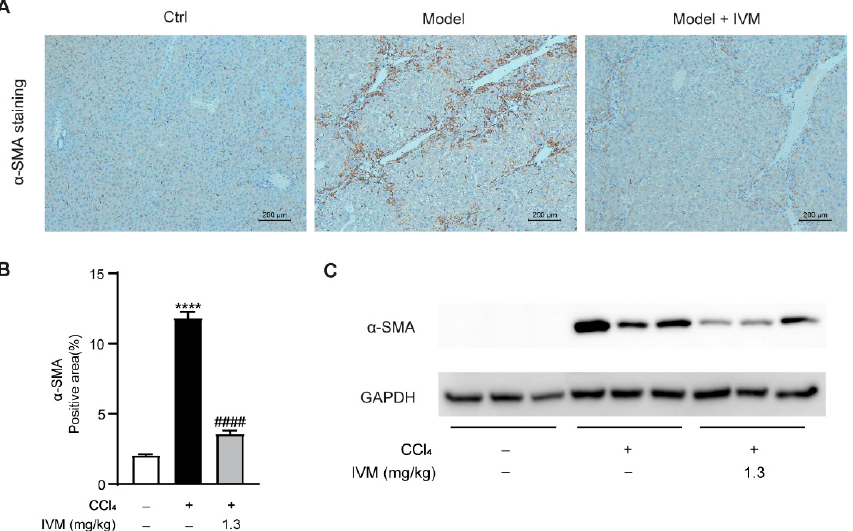
Figure 5. Effects of ivermectin on HSC activation in the liver in CCl 4 -treated mice: ( A ) IHC staining of α -SMA in the liver; ( B ) α -SMA-positive areas; ( C ) the Western blot analysis of α -SMA protein expression in the liver. Data are expressed as means ± SEM ( n = 6–8/group). Note: **** p < 0.0001 vs. control group, #### p < 0.0001 vs. CCl 4 -treated model group.